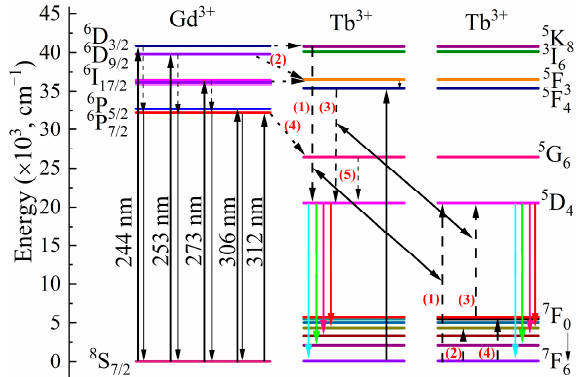
Figure 5. Energy level diagram of KGdC:Tb 3+.